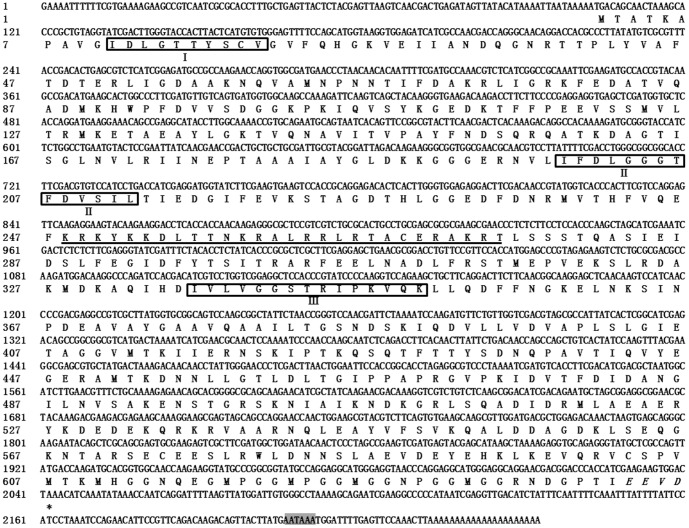
Nucleotide and deduced amino acid sequences of Lg-hsp70.The upper sequences indicate the nucleotides, and the lower sequences show the inferred amino acids. Start and stop codons are in bold. The signature sequences of the HSP70s family are shown in boxes, the nuclear localization signal sequence is underlined, the consensus sequence EEVD at the C-terminus is indicated in italics and the consensus polyadenylation signal (AATAAA) is shown in a gray box.